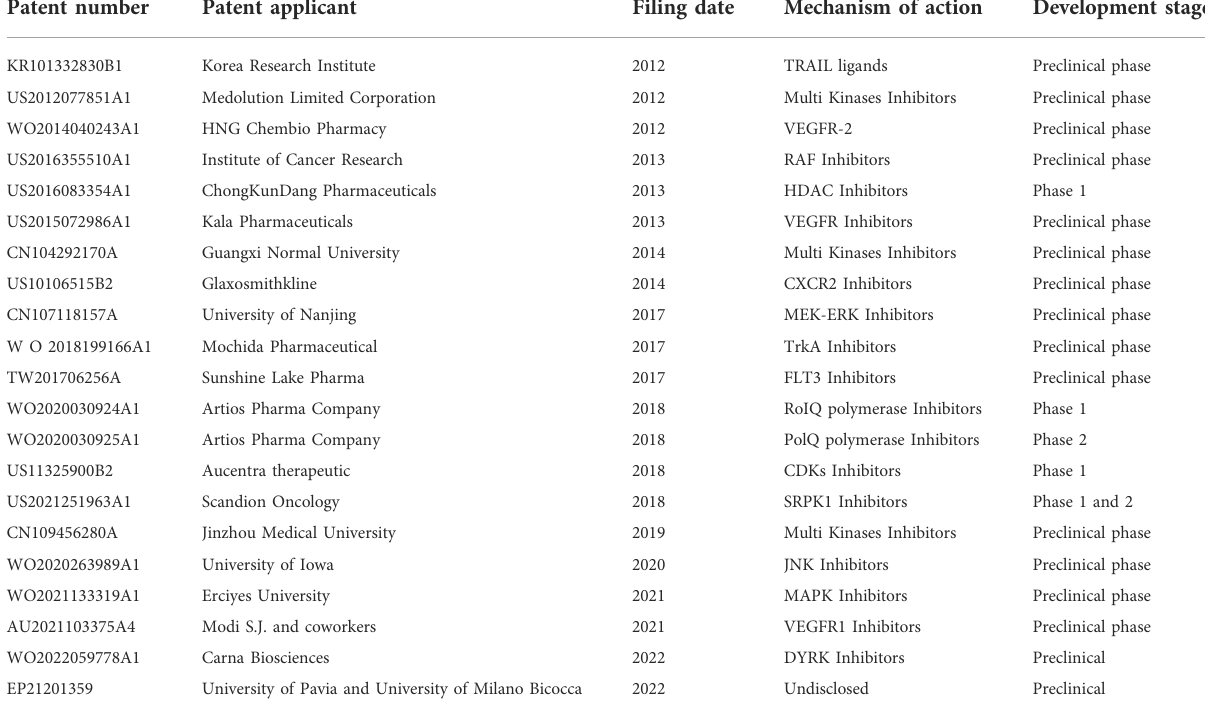
TABLE 1 Summary of cited